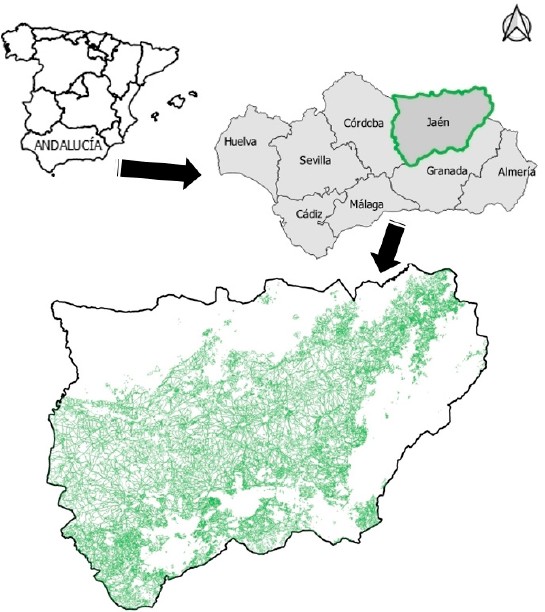
Figure 1. Localization of the study area and olive grove area, (olive grove surface in